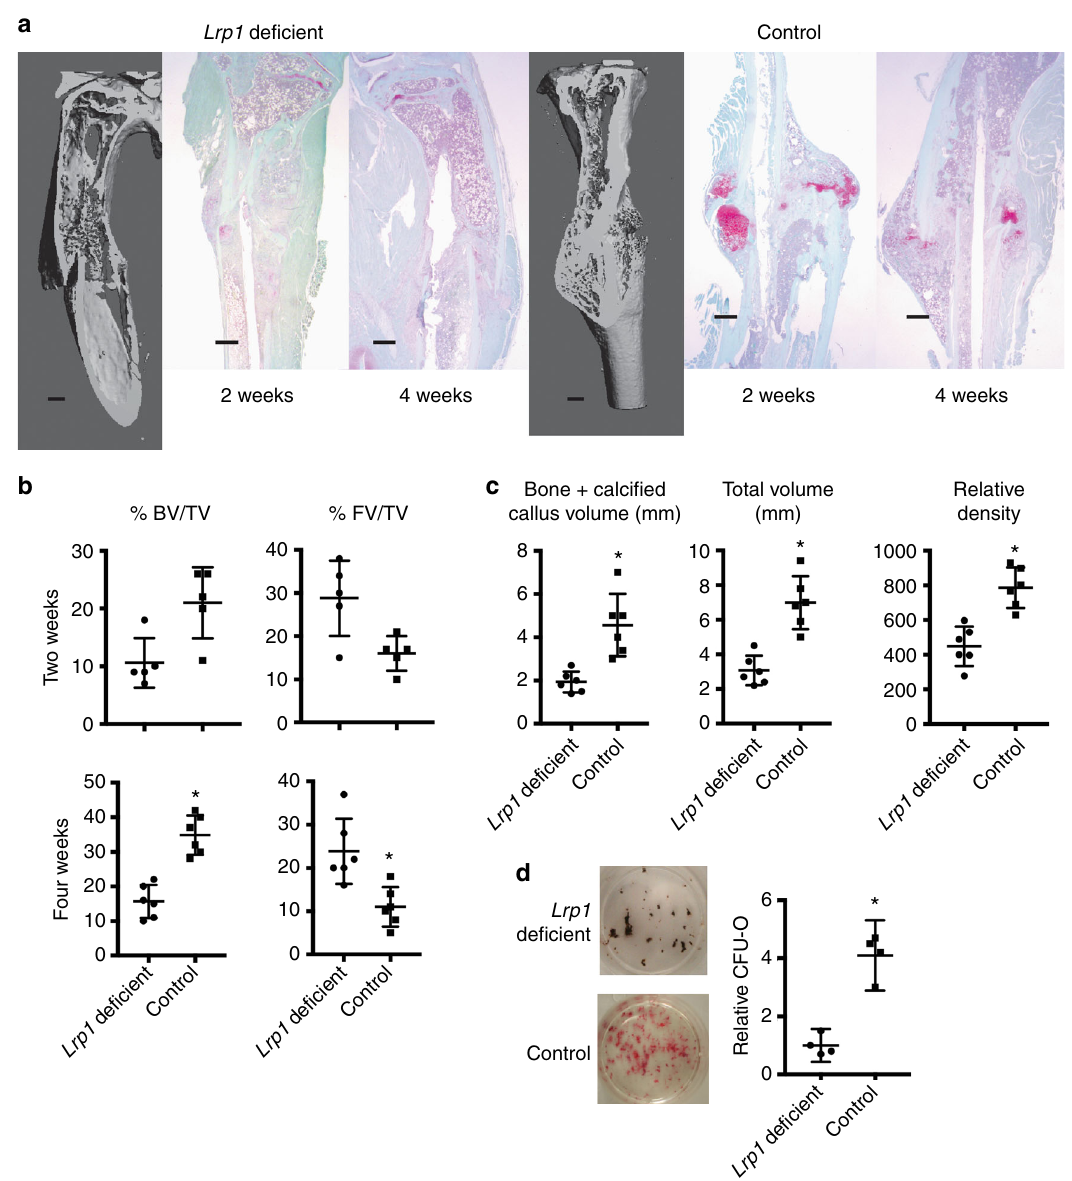
Fig. 5 Fracture healing in young mice lacking Lrp1 in macrophage cells. Fractures in LysM-cre ; Lrp1 f/f mice were compared to Lrp1 f/f control mice, showing that young mice lacking Lrp1 in macrophages have a fracture repair phenotype reminiscent of that seen in wild-type old mice. a Representative micro-CT images at 4 weeks following the fracture, and safranin O staining histologic sections 2 and 4 weeks following fracture. The size marker is 0.5 mm. b Histomorphometric data as bone volume/total volume (BV/TV) in % and total fi brous tissue/total volume (FV/TV) in %. Each data point for each mouse analyzed is shown along with the mean and 95% con fi dence interval for each experimental group. An asterisk indicates a signi fi cant difference compared to the control group ( p < 0.05). c Micro-CT data given as bone plus calci fi ed callus volume (mm 3 ), total callous volume (mm 3 ), or relative density. Each data point for each mouse analyzed is shown along with the mean and 95% con fi dence interval for each experimental group. An asterisk indicates a signi fi cant difference ( p < 0.05) compared to the control group. d Conditioned media from macrophages from LysM-cre ; Lrp1 f/f mice or Lrp1 f/f mice were used in CFU-O differentiation. Conditioned media from macrophages lacking Lrp1 resulted in fewer CFU-Os than conditioned media from control macrophages. Each data point is shown along with the mean and 95% con fi dence interval for each experimental group. An asterisk indicates a signi fi cant difference ( p < 0.05) compared to the control group. Comparison using ANOVA in ( b ) and ( c ), and paired t -test in ( d